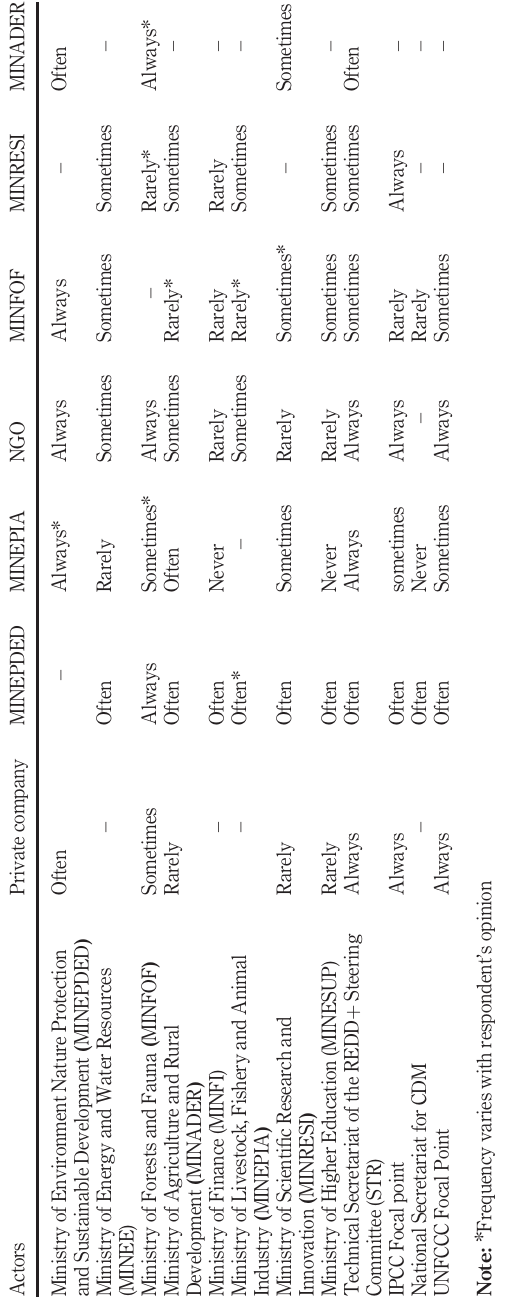
Table IV. Interaction between climate change actors in